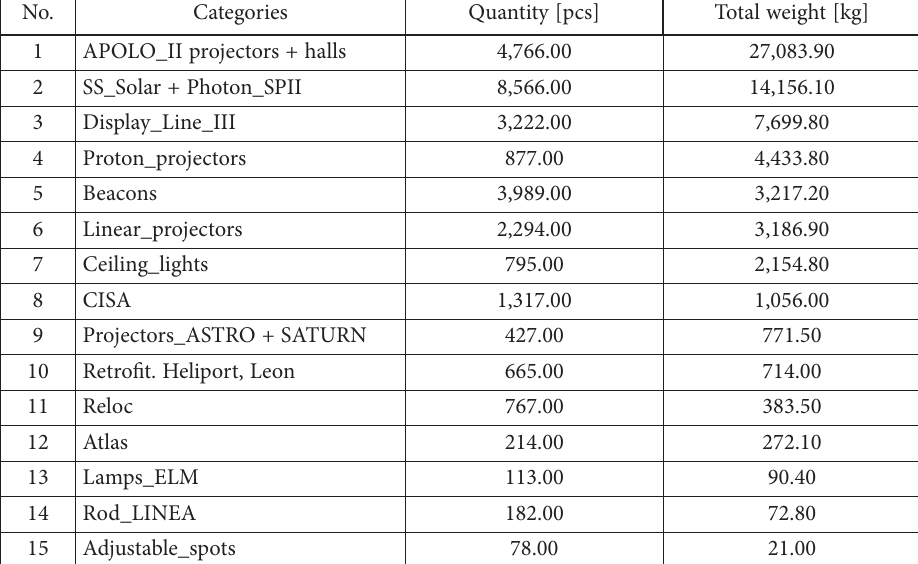
Table 6. Hierarchy of product types according to weight in total production of the